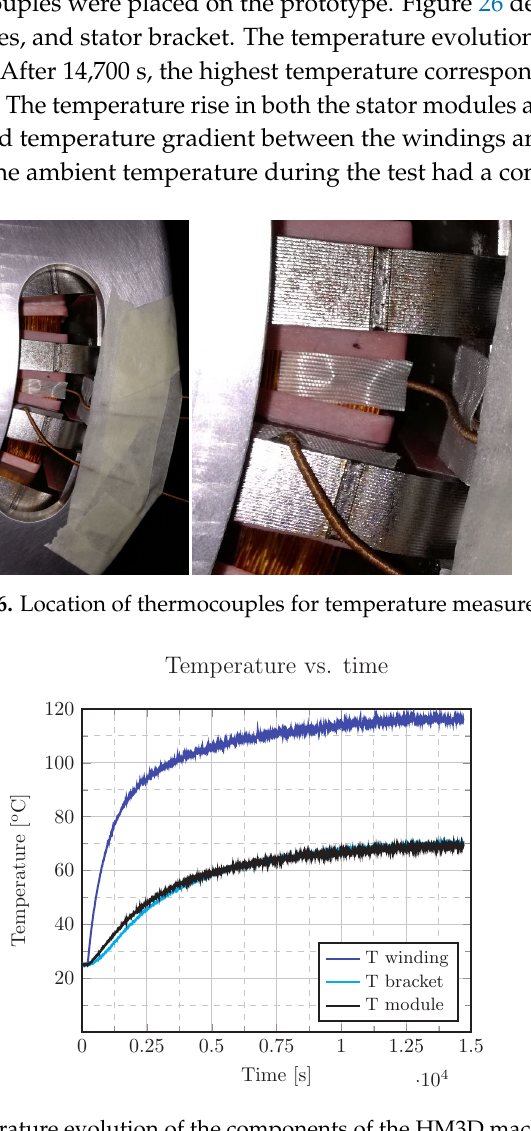
Figure 27. Temperature evolution of the components of the HM3D machine with